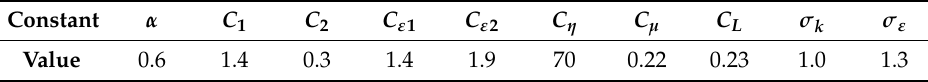
Table 1. Default value of the model constants in the v 2 – f turbulence